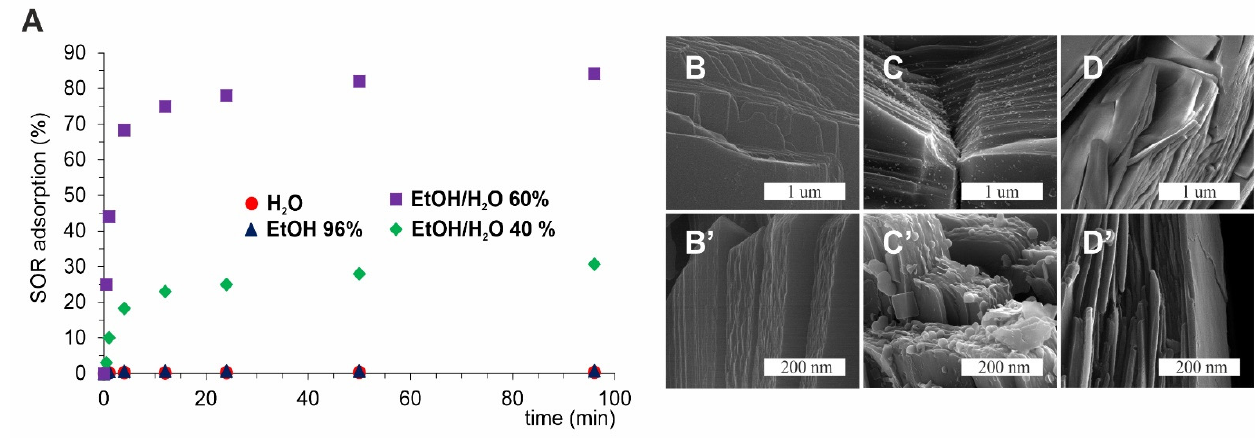
Figure 5. SOR adsorption on PPF. ( A ) Time dependent adsorption from different solutions; ( B – D , B’ – D’ ) SEM pictures of PPF, SR-SOR@PPF, and FR-SOR@PPF, respectively.